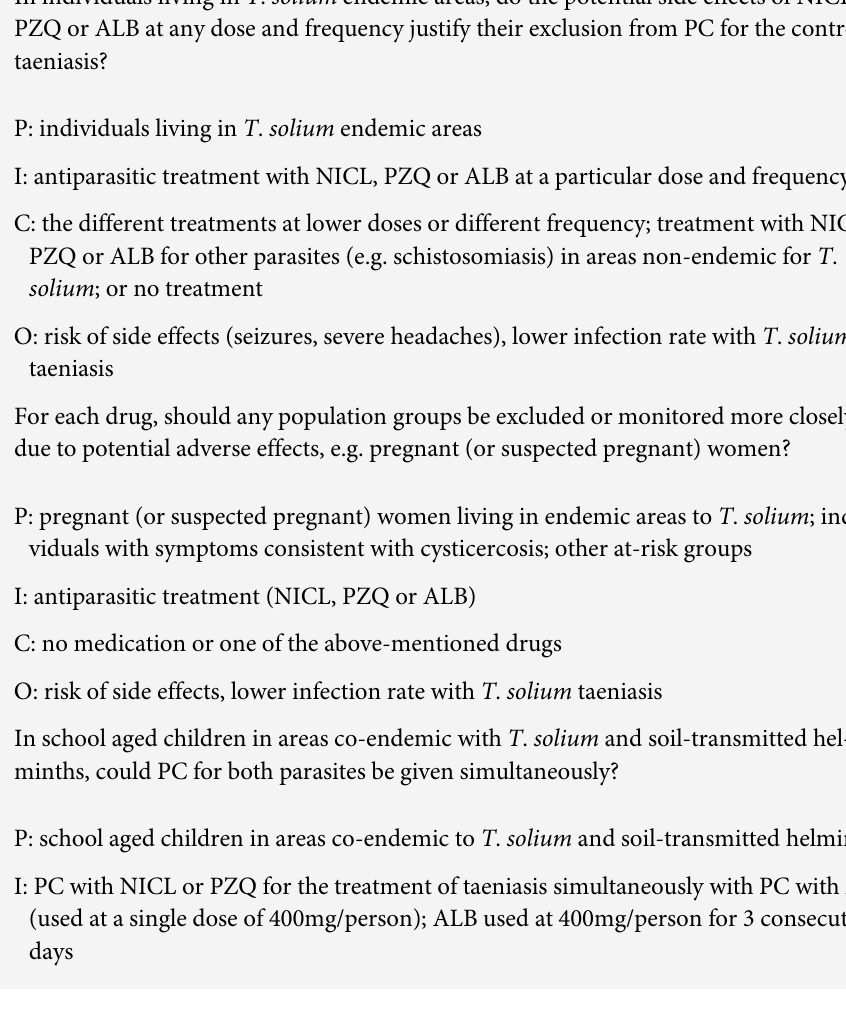
Box 1. Specific PICO (population, intervention, comparison, outcomes) questions addressed by the systematic